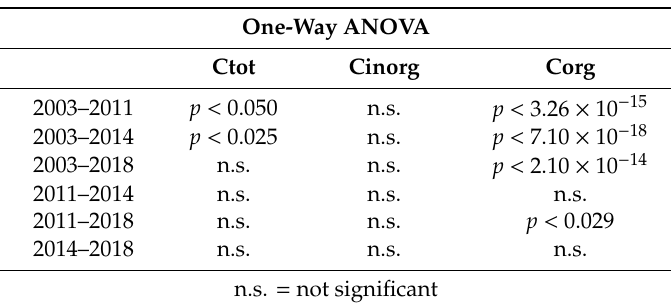
Table 1. One-way ANOVA analysis between the different sampling periods; n.s.: not significant values. One-Way ANOVA Ctot Cinorg Corg p <